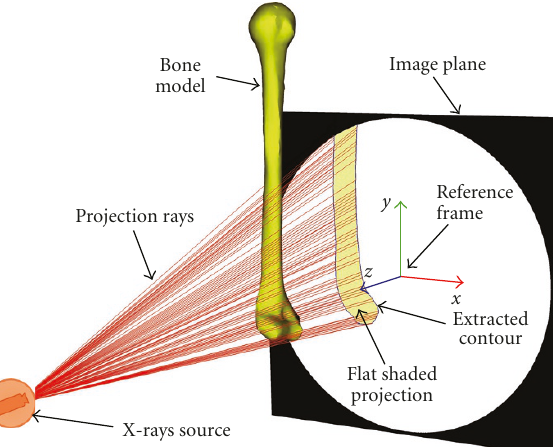
Figure 2: Perspective projection model. The bone model is placed in a reference position and a flat shaded projection is generated. The contour points are extracted and the projection lines are back projected towards the X-rays